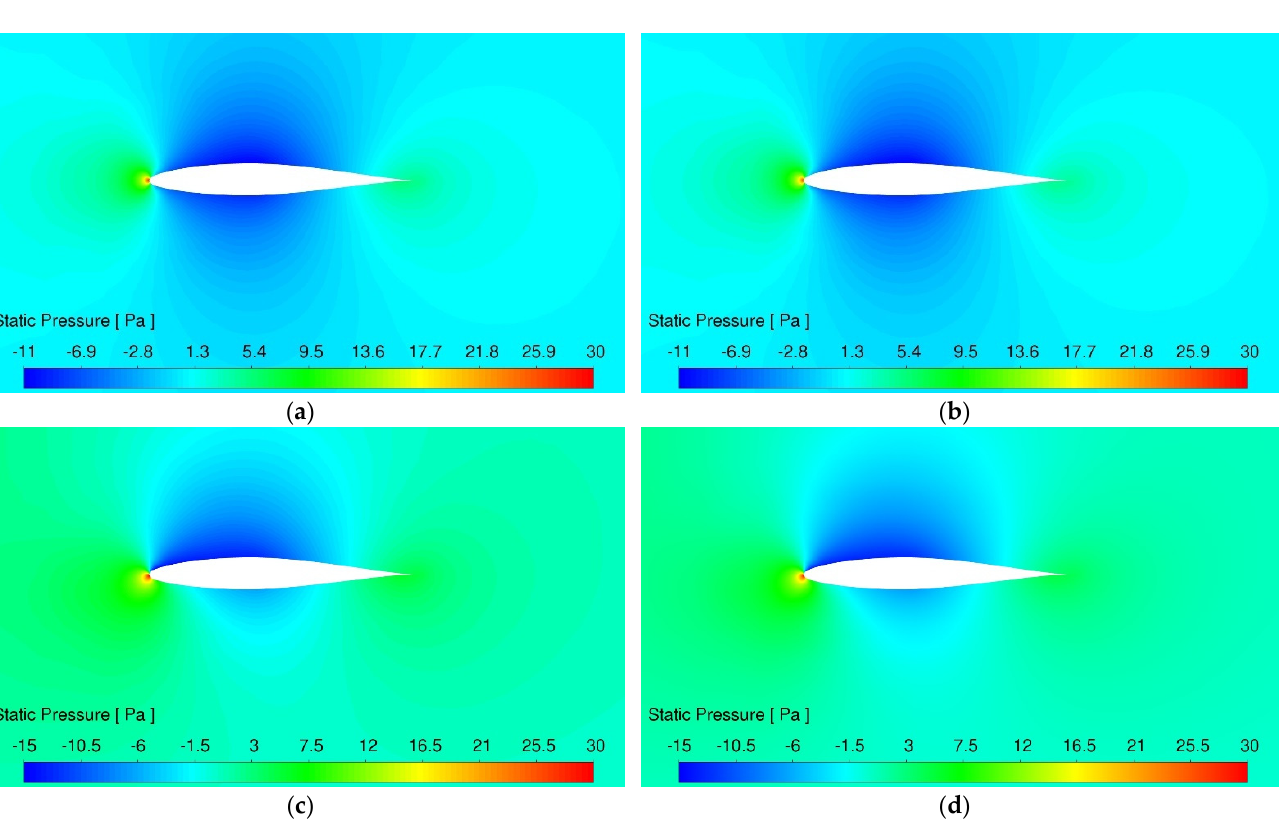
Figure 14. Velocity magnitude around airfoil at 50% of the original wingspan, with AoA = 16°: ( a ) in one-phase flow; ( b ) in two-phase flow.